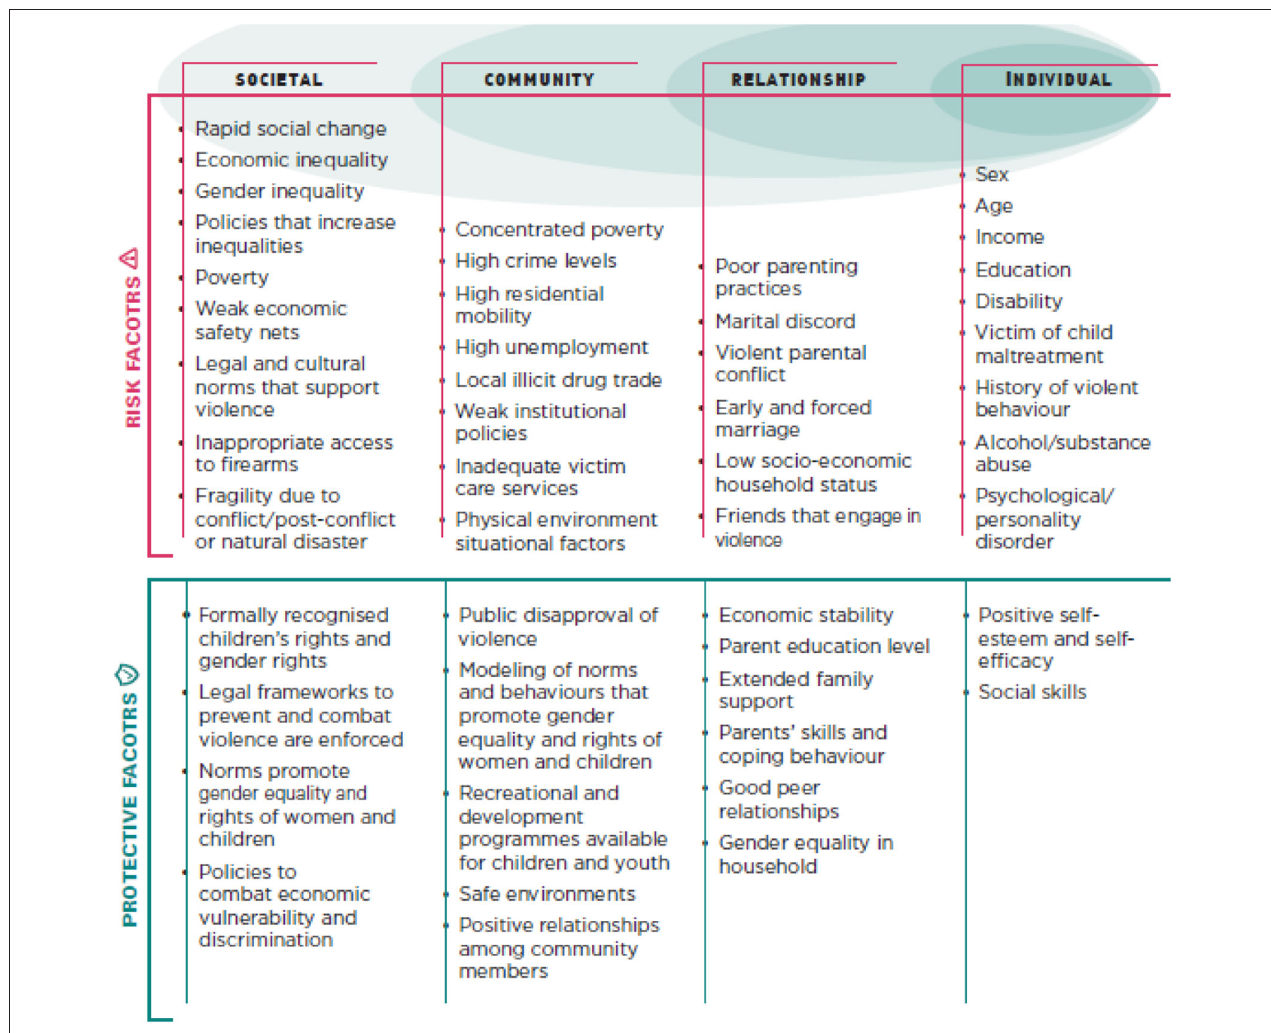
FIGURE 1 | INSPIRE’s framework of risk and protective factors (World Health Organization,